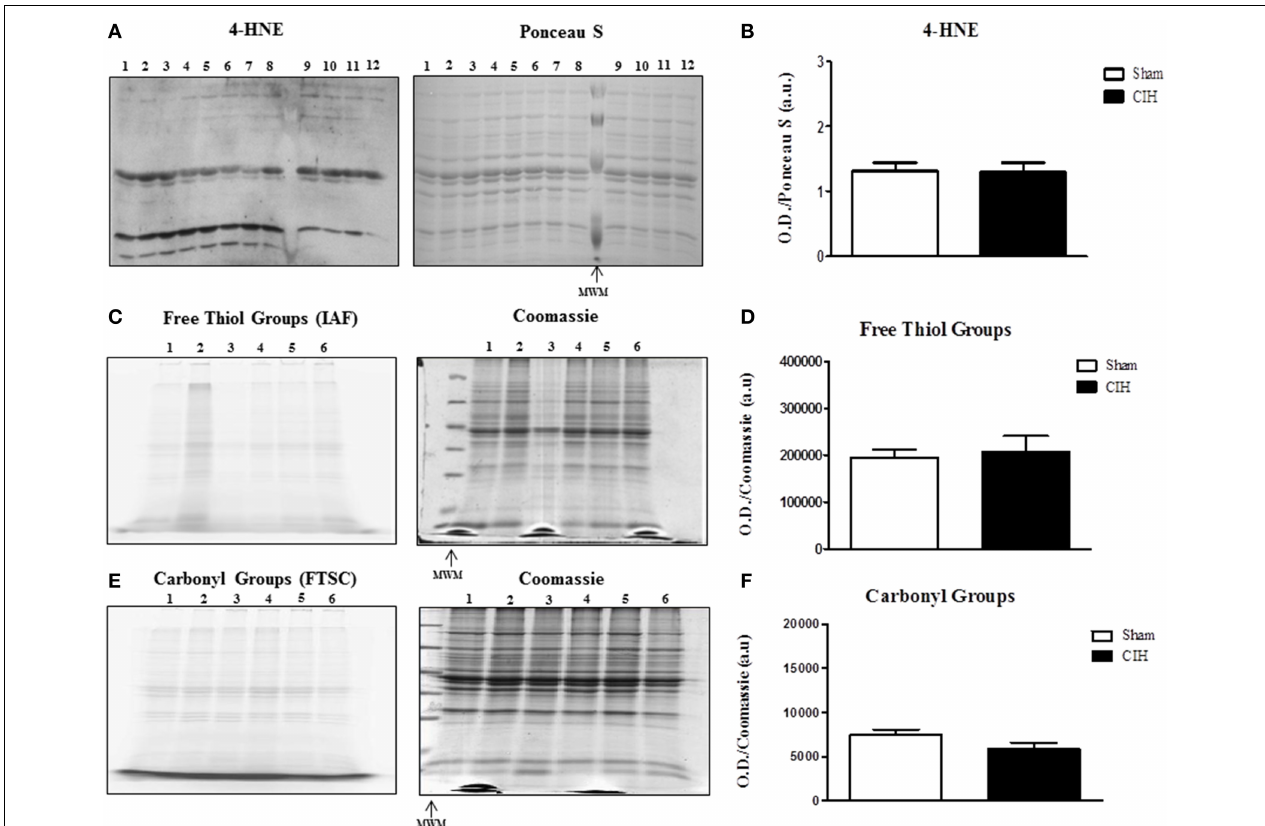
FIGURE 2 | Western blot of 4-HNE protein adducts and 1D electrophoresis to determine free thiol and carbonyl group content in the sternohyoid muscle from sham and chronic intermittent hypoxia (CIH)-exposed rats. Sham and CIH samples were loaded in alternate lanes (numbered in the figure). (A) Sternohyoid 4-HNE content together with Ponceau S stained membrane. (B) Densitometric analysis of 4-HNE protein adduct band intensities normalized by densitometric intensities of corresponding Ponceau S stained proteins expressed in arbitrary units (a.u.) from sham and CIH-exposed rats. No significant difference was observed in 4-HNE protein adduct content ( P = 0.9372; Student unpaired t -test) comparing sham and CIH-exposed sternohyoid muscles. Representative